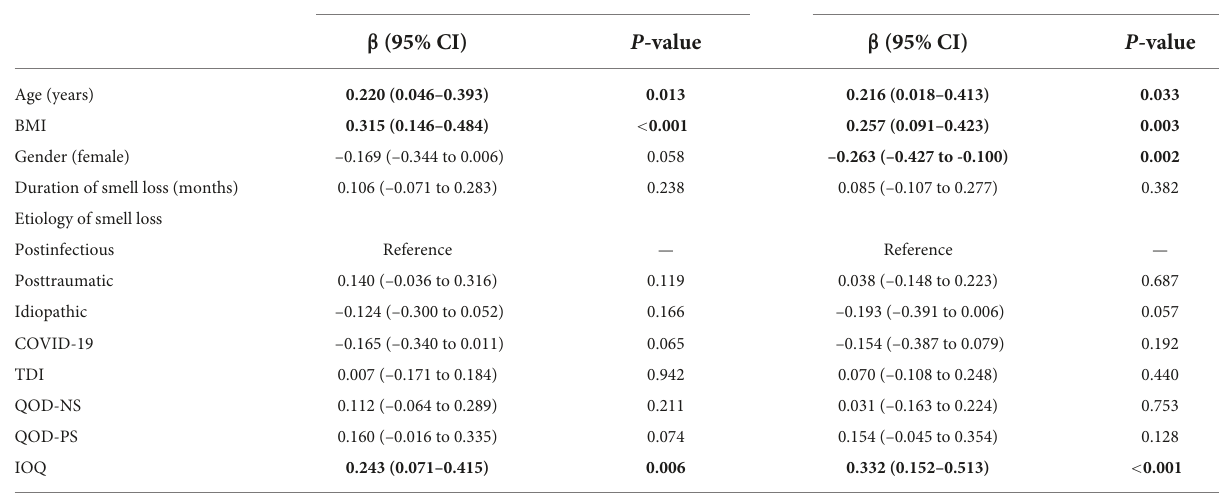
TABLE 4 Associations with restrained